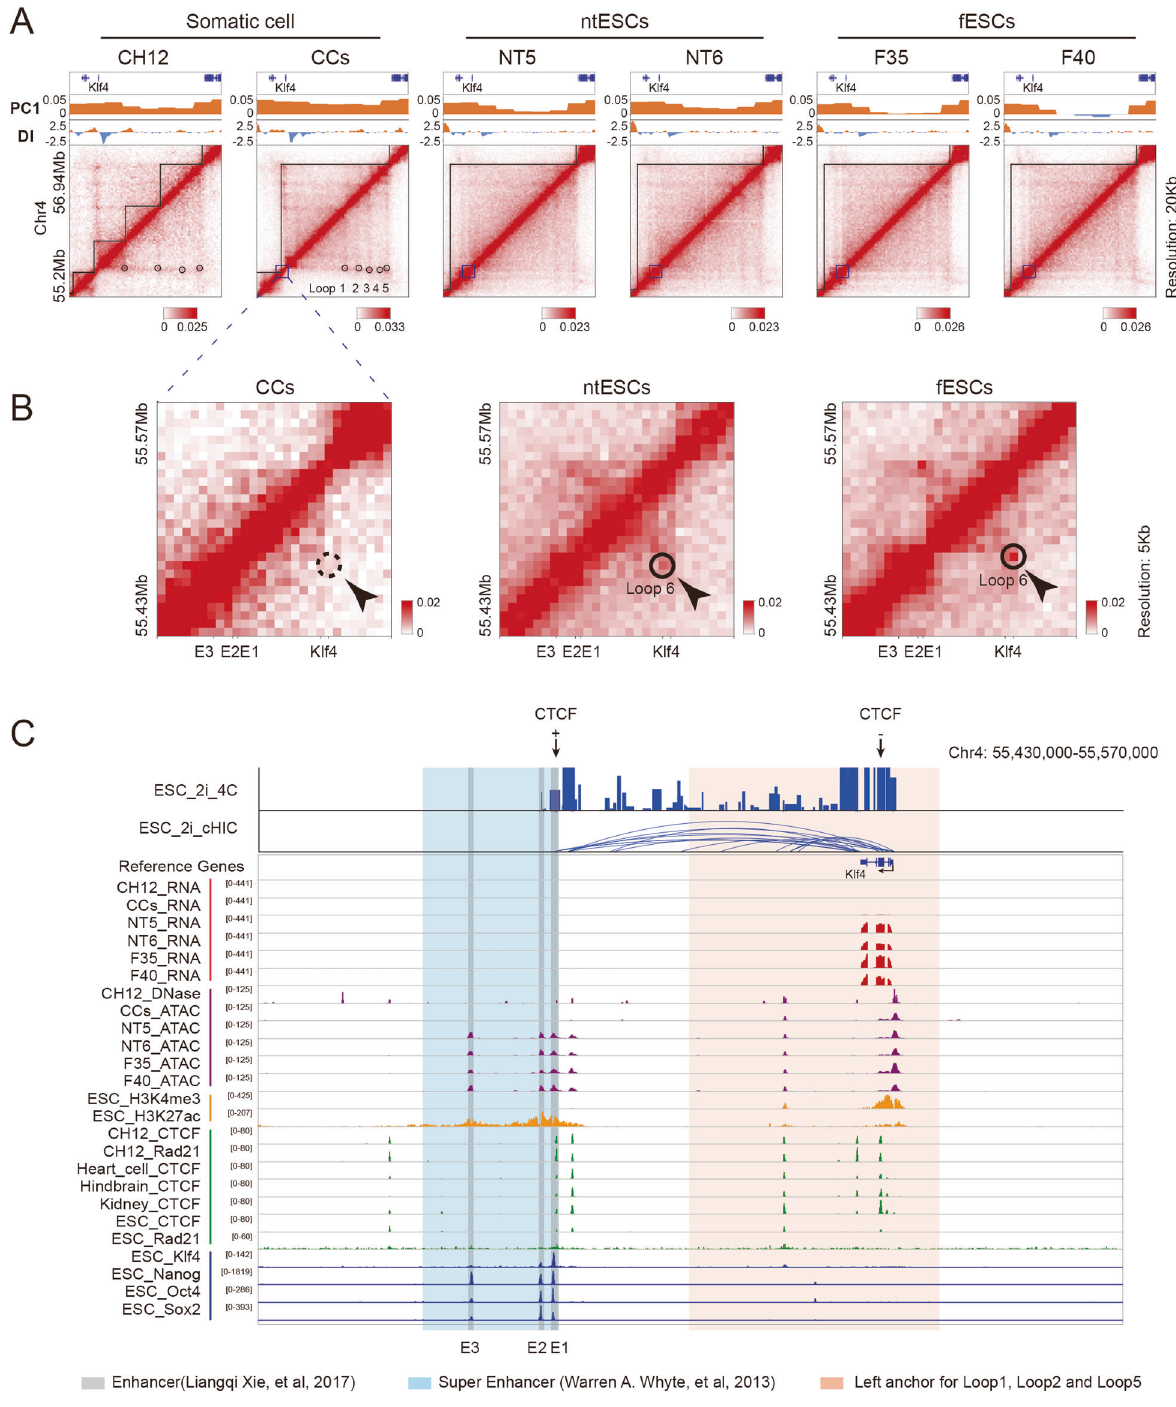
Fig. 3 Rewiring of chromatin loops around the Klf4 gene. A Heatmaps showing the normalized Hi-C interaction frequencies and corresponding PC1 and directionality index (DI) values around the Klf4 gene (Chr4: 55,200,000-56,940,000) at 20 Kb resolution for CH12 [27], CCs, NT5, NT6, F35 and F40. B Heatmaps showing the normalized Hi-C interaction frequencies around the Klf 4 gene and its enhancer regions [31] at 5 Kb resolution for CCs, ntESCs and fESCs. C The illustration of gene expression, epigenomic signals, transcription factor binding signals and chromatin interactions around the Klf4 gene. The region is the same as shown in ( B ). The regions in light red are the left anchors of loop 1/2/5 in CCs and the regions in light blue and gray are the reported super enhancer [30] and the enhancers